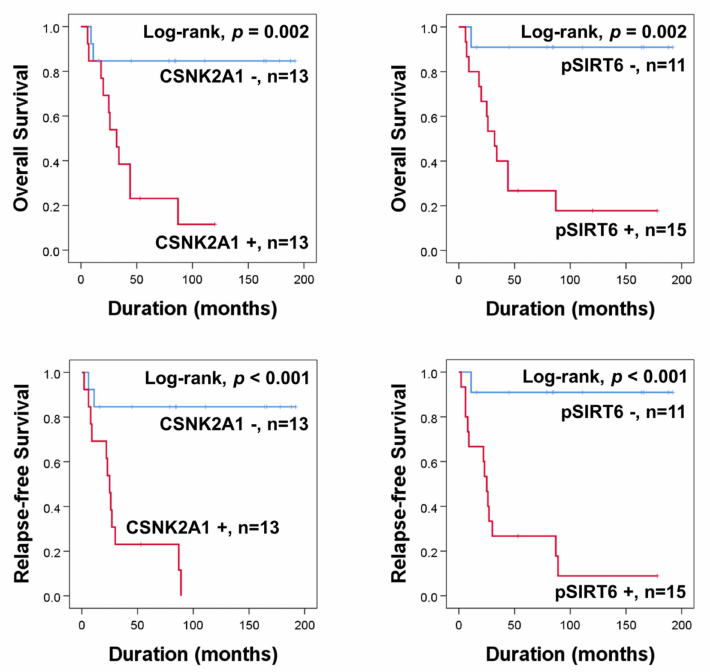
Figure 2. Kaplan–Meier survival curves for overall survival and relapse-free survival according to ex- pression of CSNK2A1 and pSIRT6 in 26 osteosarcoma patients who received adjuvant chemotherapy. 3.2. The Expression of CSNK2A1 Is Involved in the Resistance to the Anti-Proliferative Effect of